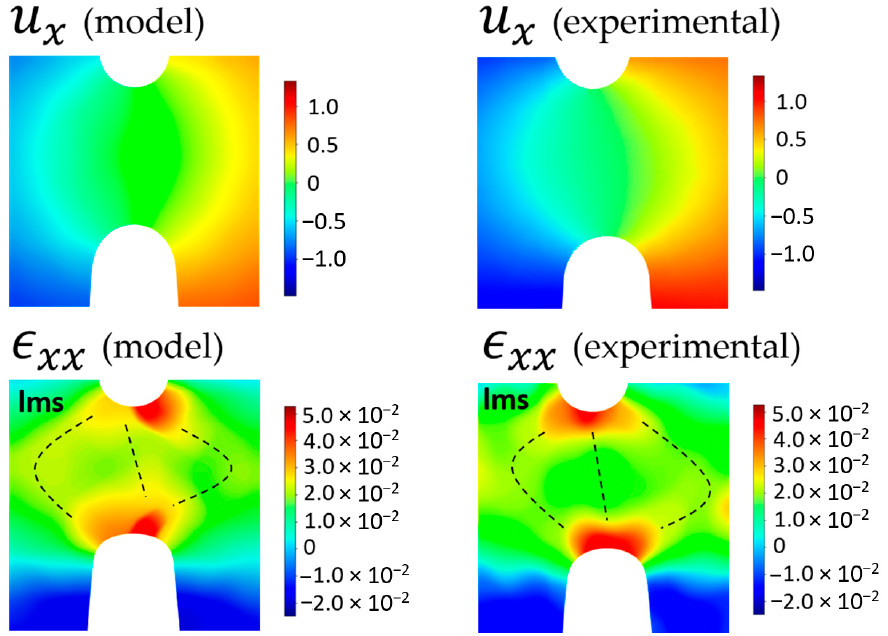
Figure 6. Correlation of modeled (left) and experimental (right) strain fields.